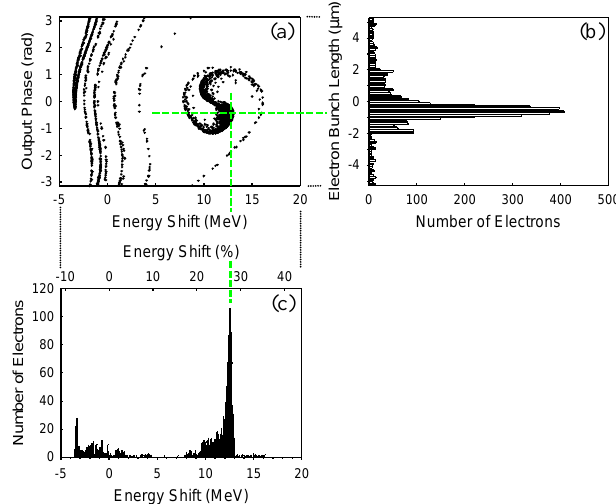
FIG. 10. (Color) Model predictions for STELLA-II for 100 GW laser power and 25% taper in the accelerator un-